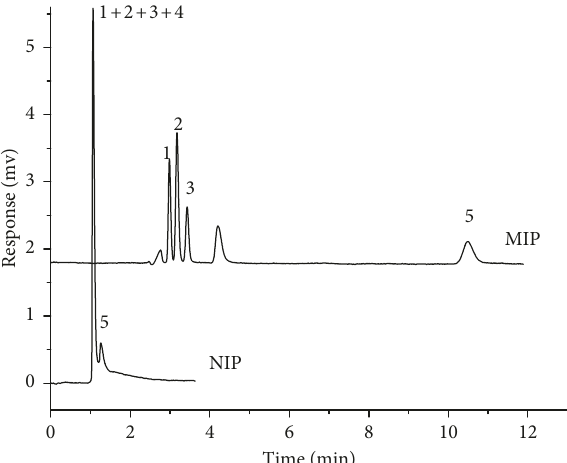
Figure 2: Comparison between MIP monolith and NIP monolith. Capillary column: 51cm column length; 30cm effective length.